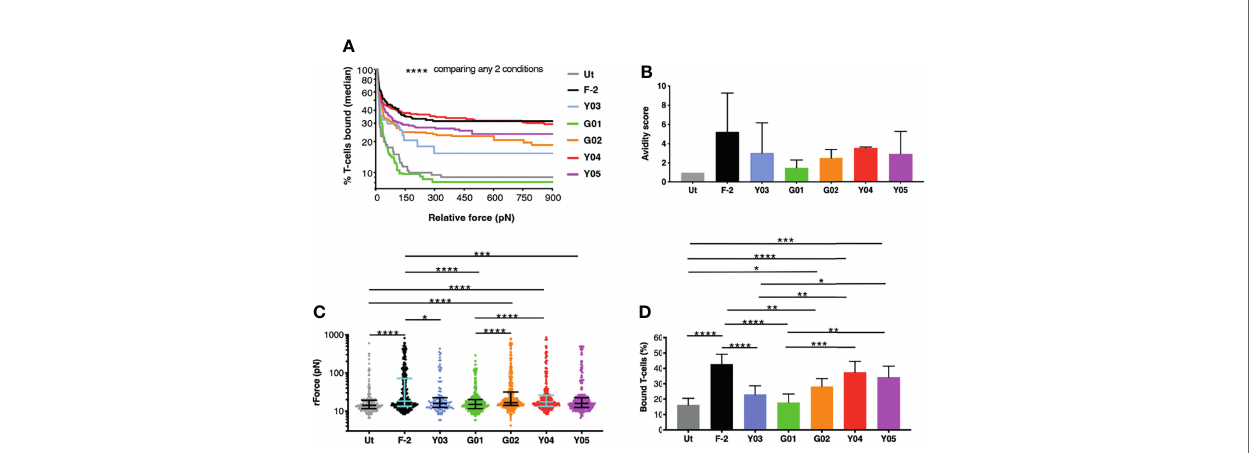
( Figure 1C ). Cell surface 1:1 co-expression of CAR and CCR components was demonstrated by fl ow cytometry ( Figure 4A ).